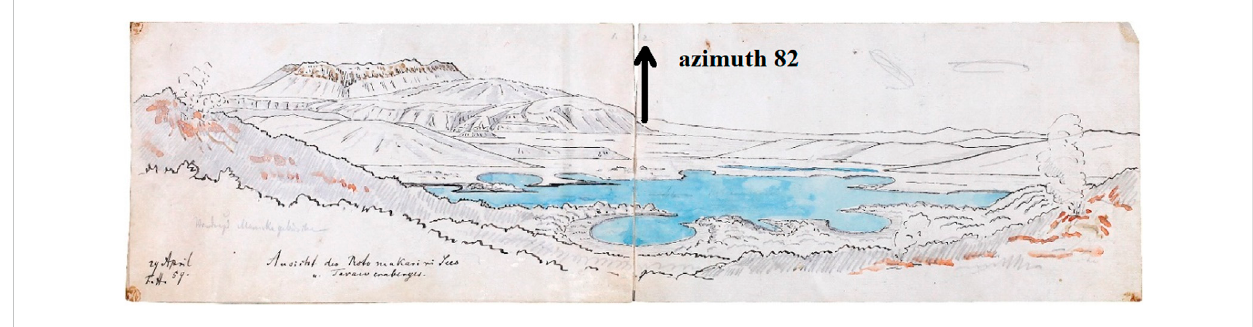
FIGURE 13 View ofthe Rotomakariri(cold lake) with theTarawera mountain looking east, byFerdinand Hochstetter,29 April 1859 (Nolden